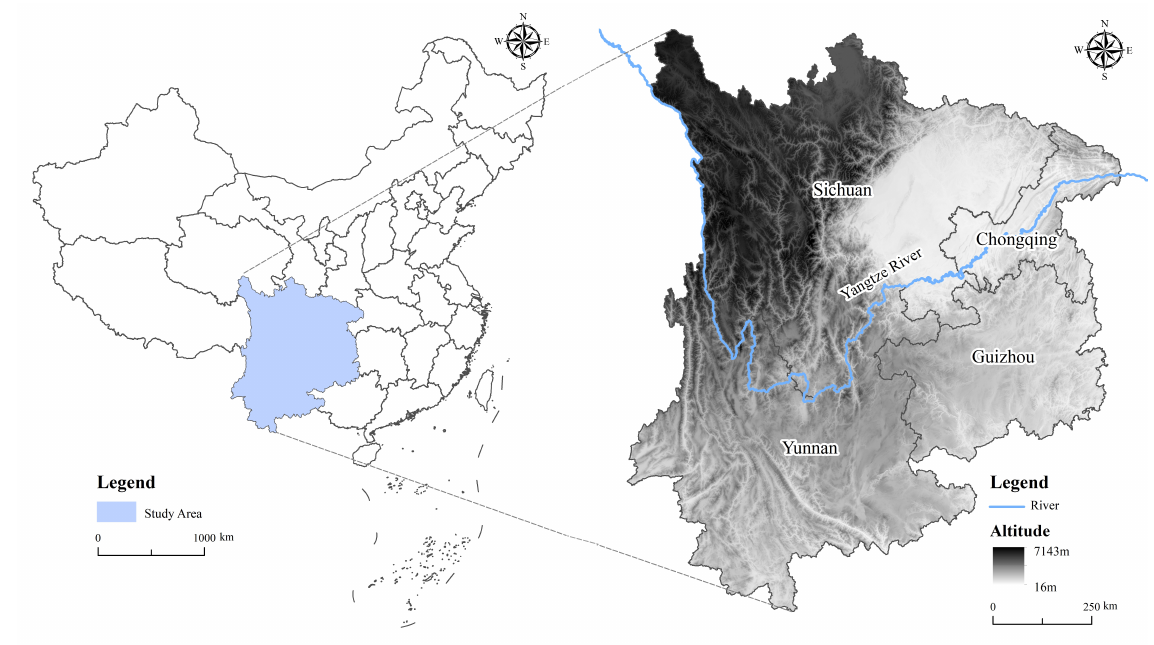
Figure 1. The geographical location of the study